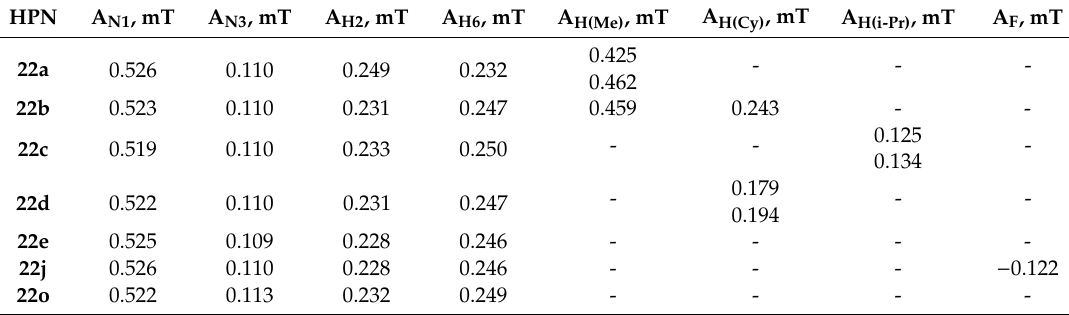
Table 4. EPR parameters for HPNs 22a–o calculated at the UB3LYP/6-31G(d) level of theory; the solvent effect was taken into account via the CPCM-model (solvent: toluene).